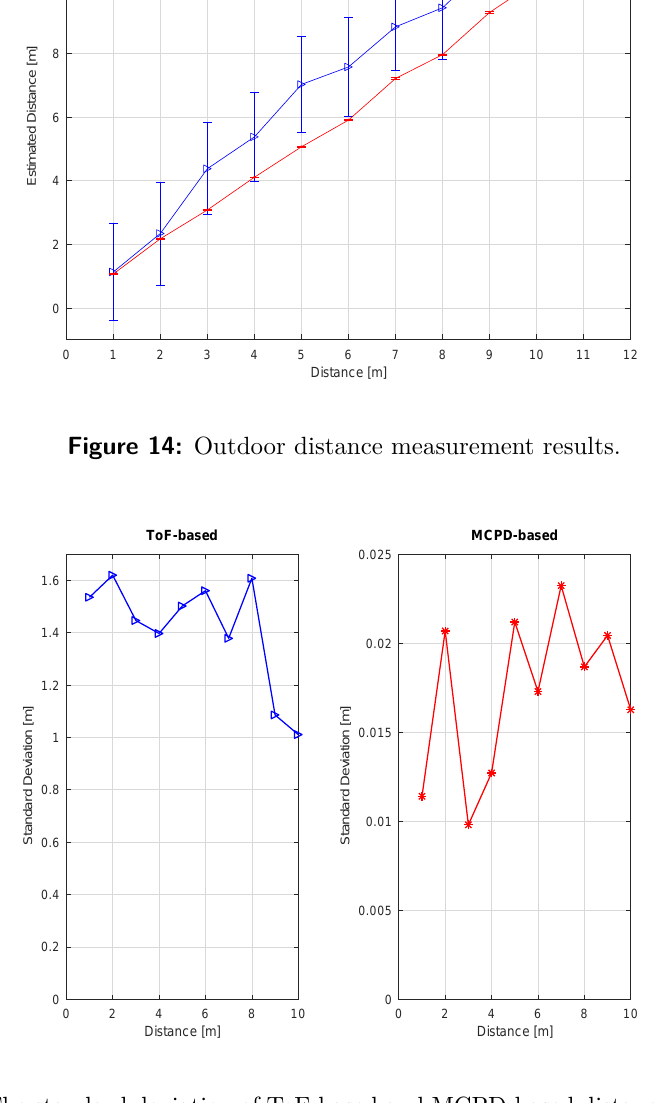
Figure 15: The standard deviation of ToF-based and MCPD-based distance